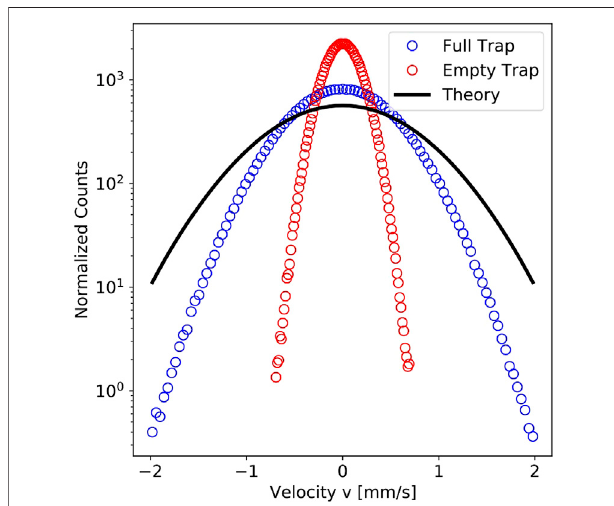
FIGURE 6 | Normalized velocity distribution (refer to Eq. 1 with M replaced by M * ) obtained for the 2.15 µm diameter AuPS particle without additional heating at room temperature T 0 (cid:2) 23 . 5 ° C. The bin size was chosen to be 60. Blue and red circles are experimental data points for full trap and empty trap measurements. The black solid line shows the theoretical expectation for Maxwell-Boltzmann distribution at room temperature for the particle effective mass of M * (cid:2) 8 . 2 × 10 − 12 g.